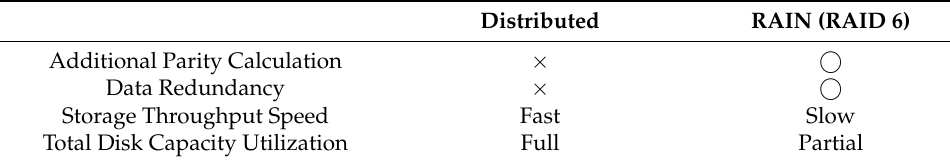
Table 8. Comparison between distributed and RAIN layout. Distributed RAIN (RAID 6) Additional Parity